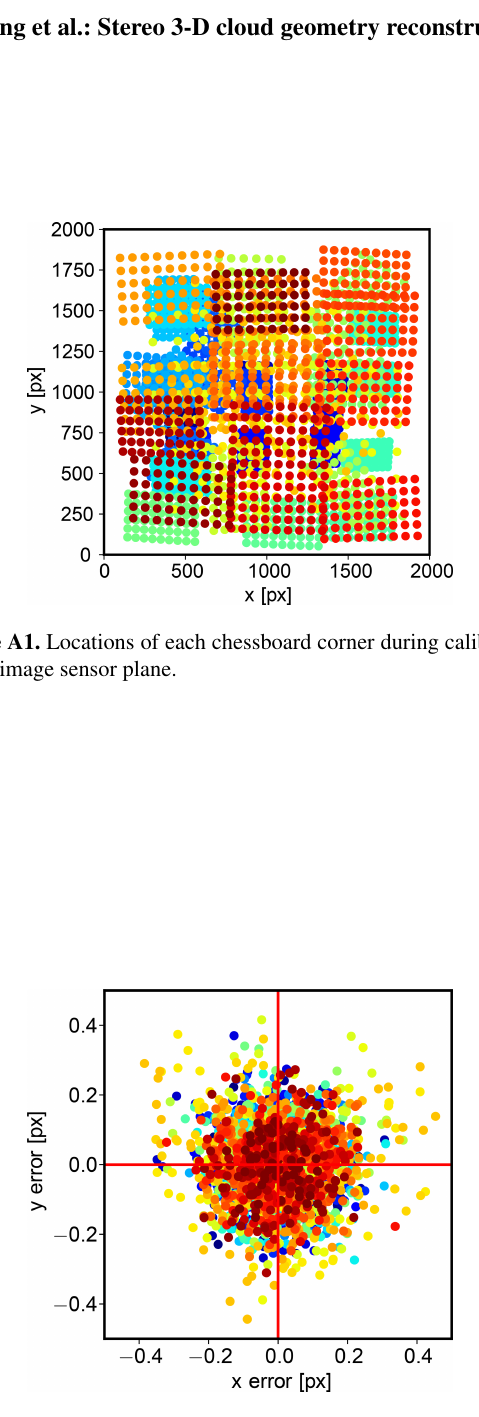
Figure A2. Reprojection error: difference between the actual posi- tion of the chessboard corners and the calculated positions of the chessboard corners after applying the camera calibration. The av- erage reprojection error is about 0 . 15pixels. Note that the actual chessboard corner locations can be found far into sub-pixel accu- racy by following the lines along the edges of the